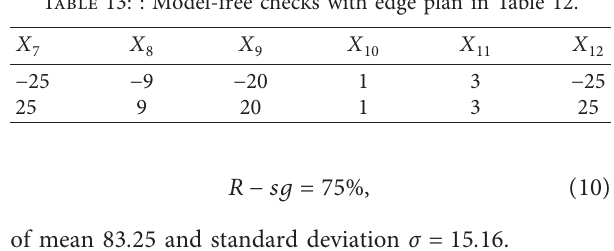
of mean 83 . 25 and standard deviation σ � 15 . 16.